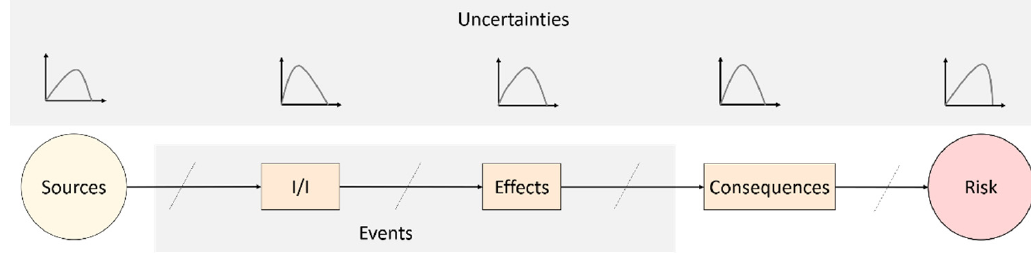
Figure 1. Risk chain of I/I illustrating the relationship of components defining risk in the framework.